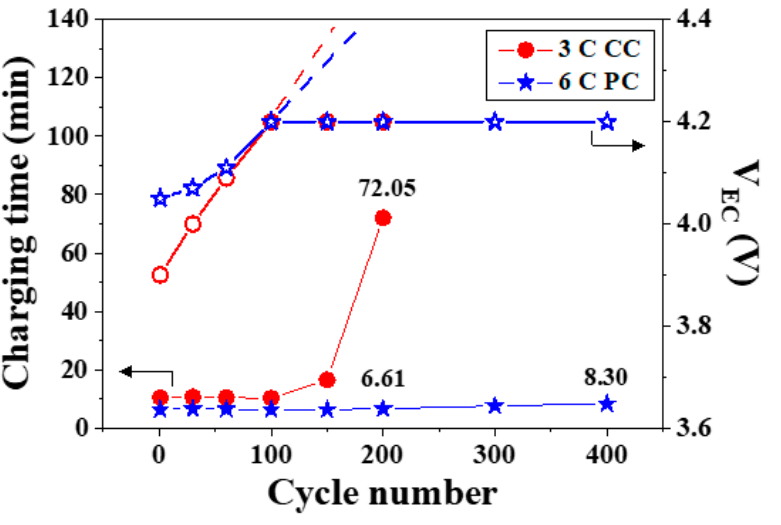
Figure 6. End voltage and elapsed time for each method.